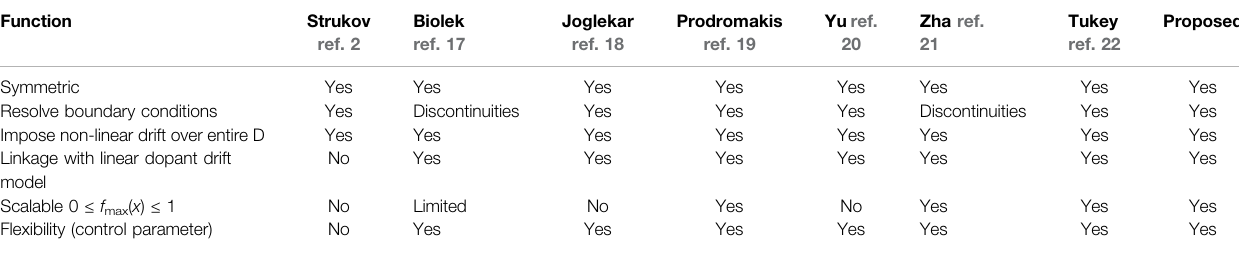
Biolek Joglekar ref. 2 ref. 17 ref. 18